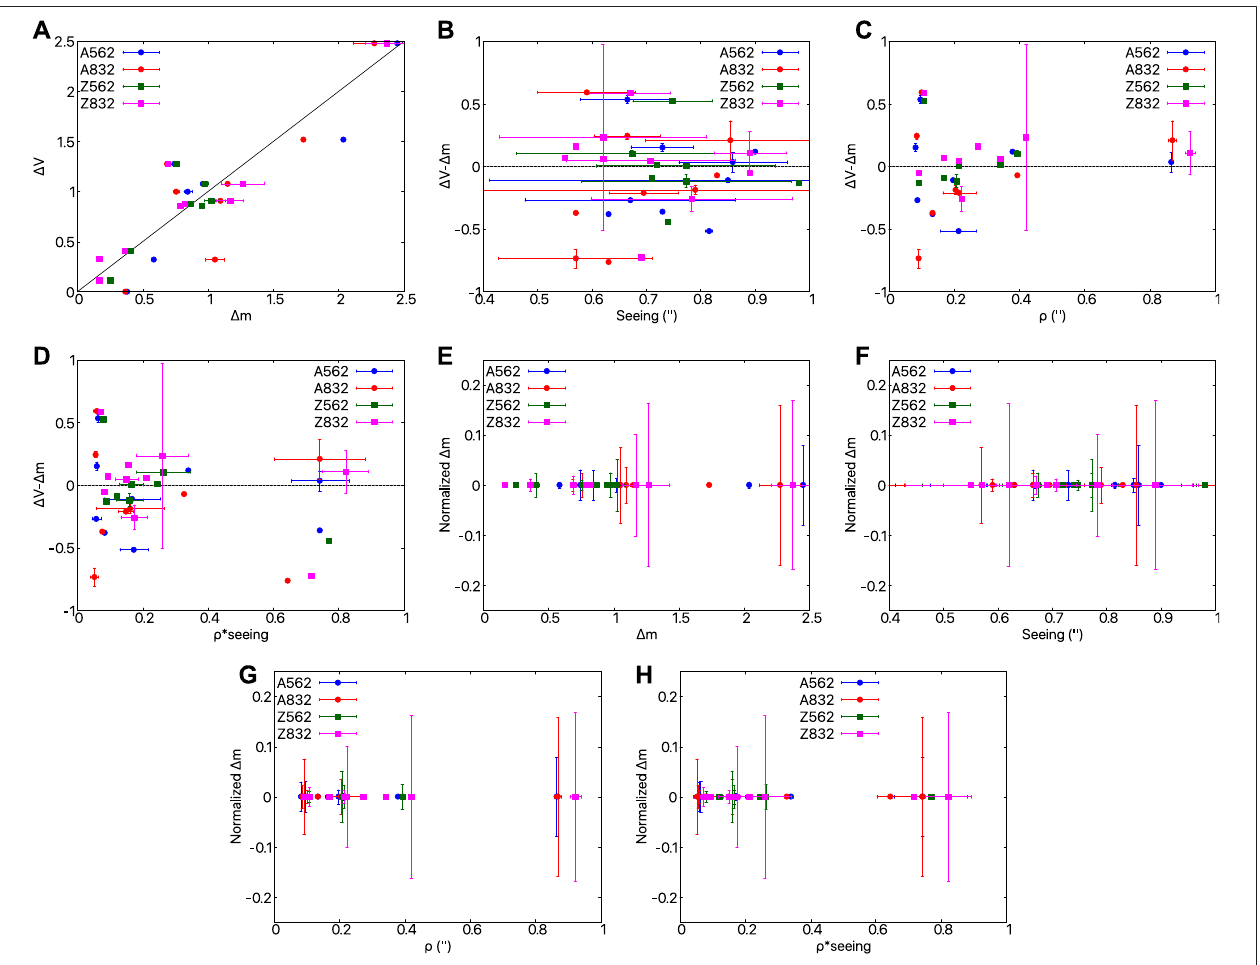
FIGURE6| Illustrativeplotsshowingtherelationshipbetweenourderived Δ mfrom ‘ Alopeke(blueandredcircles)andZorro(greenandpinksquares)observations of the calibration binaries compared with Δ V values taken from the WDS catalogue. For stars that were observed more than once, horizontal and vertical bars are given showing the standard deviation of the measurements. The points without such bars were only observed once. In sub fi gure (A) , we compare our run of magnitude differences in both fi lters ( Δ m) with that of Δ V from the WDS. We would not expect this to be a perfect match as we are comparing two different photometric fi lter systems,butwenotethesimilartrendinthevalues.Our562 nmvaluesareclosertoVthanthe832 nmvalues,thustheyareabettermatchtoV.Forthesamesampleof calibration binaries, we present the measured difference in the stellar component magnitudes ( Δ m) but normalized by subtracting the average Δ m for each observation. This allows us to intercompare our Δ m measurements over their different values and in a variety of observing conditions. For stars with more than one observation, verticalbars were plotted showing thestandard deviationofthe measurement and therange inour derived measurements. Plots (B) , (C) , and (D) show thedifference in Δ magnitudeswithrespecttoSeeing( ″ ),separation( ρ ),andtheproductofseeingandseparation,respectively.Theplotsshowthenormalized Δ mwithrespectto (E) the observed range in Δ m, (F) seeing, (G) binary separation, and (H) the product of separation*seeing. We note from these plots that our narrow-band instrumental photometry generally follows a standard photometric system even as observing conditions